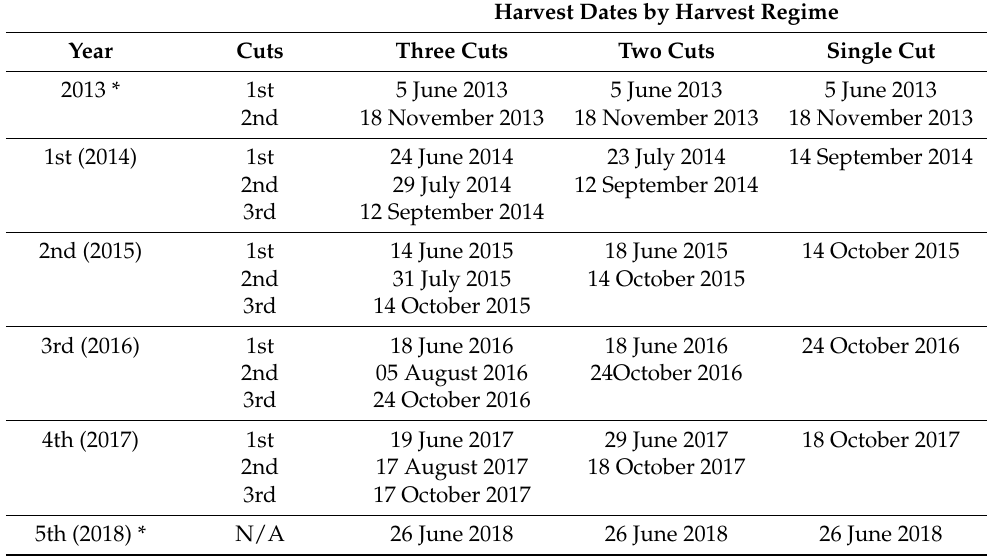
Table 1. Actual harvest dates for three different cutting frequencies (cuts year − 1 ) on newly established NWSG stands recorded from 2013 to